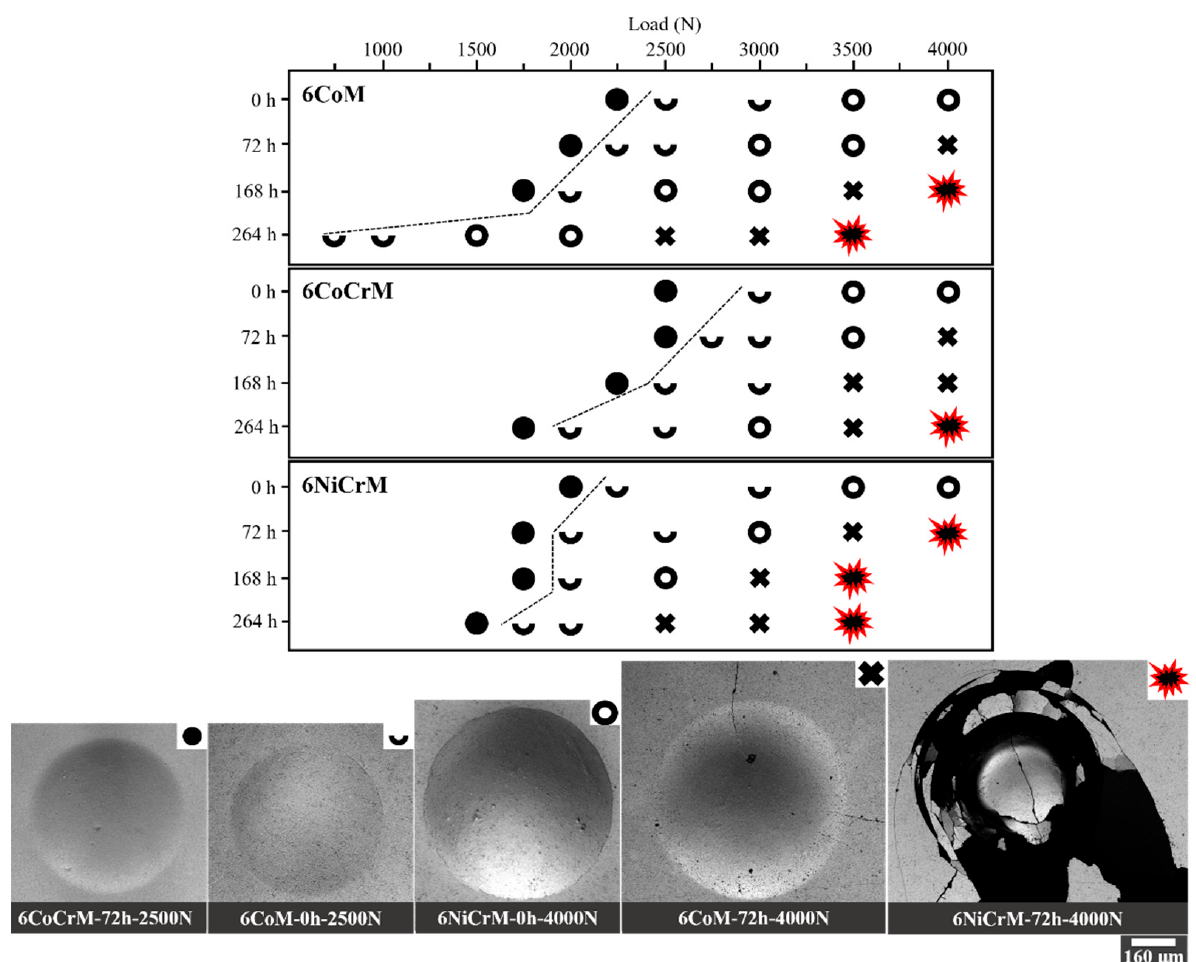
Figure 5. Damage evolution diagram for 6CoM, 6CoCrM, and 6NiCrM samples as a function of indentation load and corrosion time. Main damage features ascribed to each symbol (no cracks, partial ring crack, full ring crack, radial crack, and specimen breakage) are shown within the legend, including images of representative events (adapted from Ref. [45]).